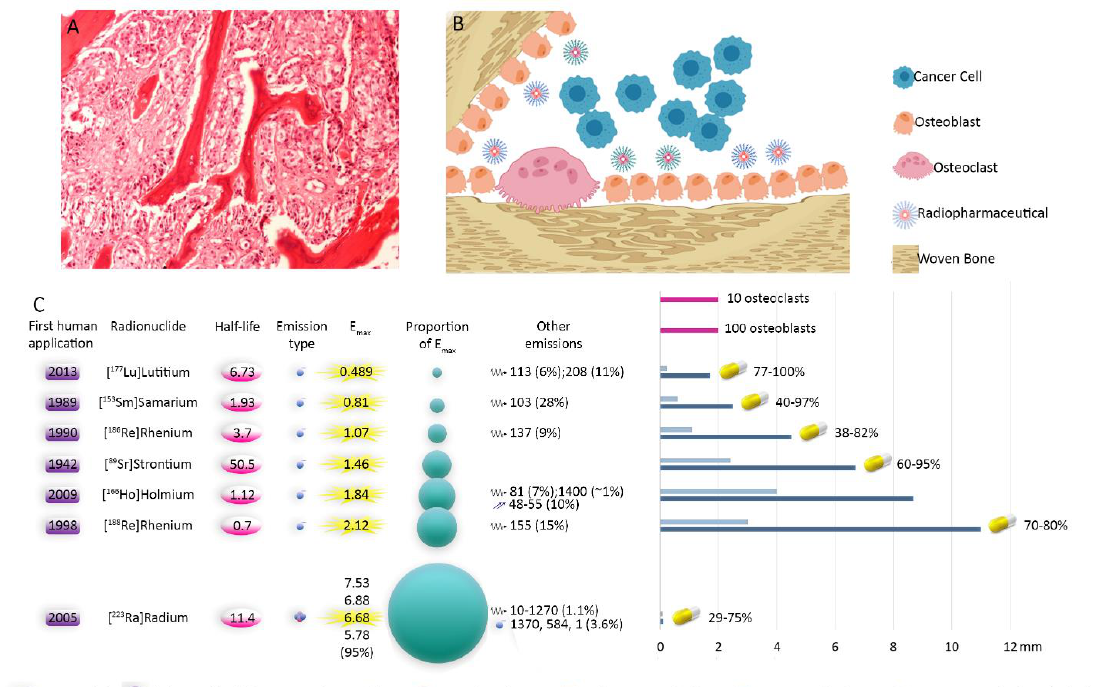
Figure 3. Illustration of bone metastases and physical characteristics of radiopharmaceuticals. Cancerous cells from prostate origin produce cytokines activating osteoblasts. On the other hand, their homing is facilitated by secreted factors from osteoblasts. In addition, chemoattractants created by newly formed bone matrix increase the invasiveness of cancer cells. This cycle continues destructing the bone. Bone-seeking radiopharmaceuticals reside in regions with bone turn over. Accumulation of radiopharmaceuticals in the osteoblastically active regions, which is induced or increased significantly by tumoral cells infiltration, leads in mainly irradiation of metastatic sites with only minimal impact on the normal tissues. Eventually, the tumoral tissues shrink, osteoblastic activity is inhibited and stimulation of the periosteal pain receptors is reduced [10,31]. ( A ) Histopathology image of bone metastasis; ( B ) schematic illustration of bone metastasis with predominant osteoblastic proliferation. Note the accumulation of radiopharmaceuticals in areas with osteoblastic activity. Depending on the range of the agent, the cancerous and normal cells will be a ff ected; ( C ) physical characteristics and e ffi ciency of radiopharmaceuticals. The response rates (Table 1) pertain to bone-seeking pharmaceuticals labeled with the mentioned radionuclides. E max : Maximum particle energy. First human application